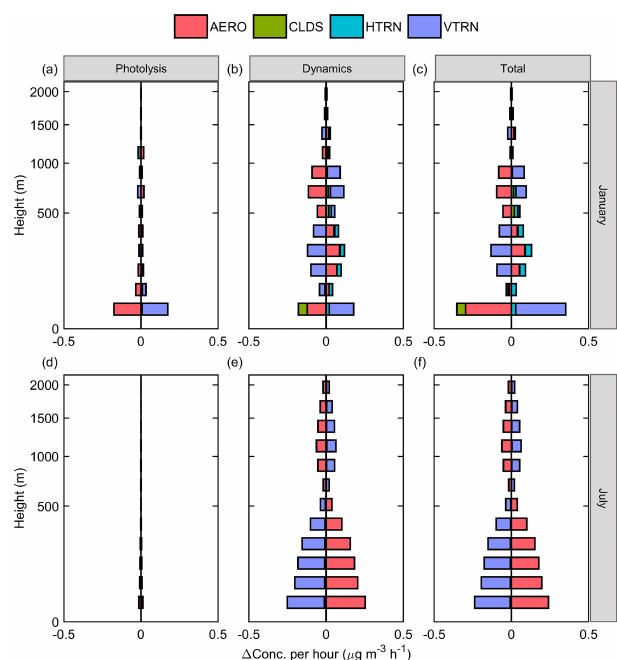
Figure 9. Vertical distribution of the responses of the main process of nitrate to ADEs in the Jing-Jin-Ji (JJJ) region in January (a, b, c) and July (d, e, f)